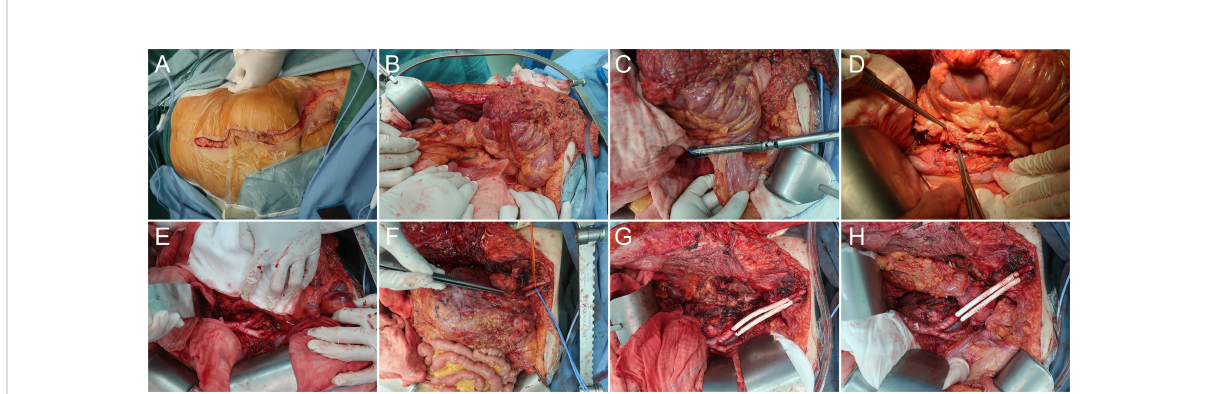
FIGURE 2 Representative case of en bloc resection of retroperitoneal sarcoma encasing the left iliac vessels with graft interposition via the abdominoinguinal approach. (A) A left-sided abdominoinguinal incision is made from approximately 5 cm above the umbilicus to approximately 2 cm above the pubic symphysis, then from the lower end point to the left mid-inguinal point, and then vertically into the femoral triangle. (B) The entire lower abdominal wall could be laterally retracted and full access to the abdomino-pelvic organs is acquired. (C) The in fi ltrated sigmoid is transected by GIA. (D) The root of the inferior mesenteric artery is dissected. (E) The left common iliac artery and vein are dissected from the bifurcation of the aorta and the apex of the triangle of Marcille to the point of involvement by the tumor. (F) The left external iliac artery and vein are dissected in the groin, released by dividing branches and tributaries, and lifted with vessel loops distal to the point of involvement. (G) After removing the tumor, the en bloc resected iliac artery and vein are replaced with a graft (polytetra fl uoroethylene [PTFE] with integrated rings, 8 mm in diameter) with a 5-0 Prolene running suture. (H) Anastomosis of the descending colon to the rectum is